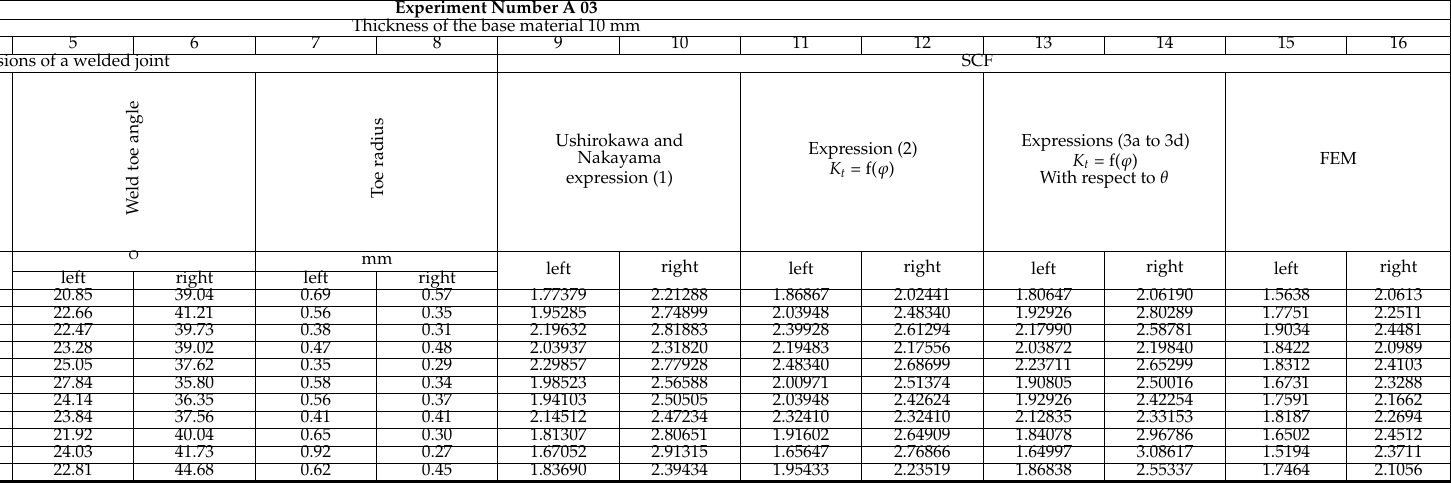
Table 3. Measured geometric parameters and calculated SCFs for sample A3 in band